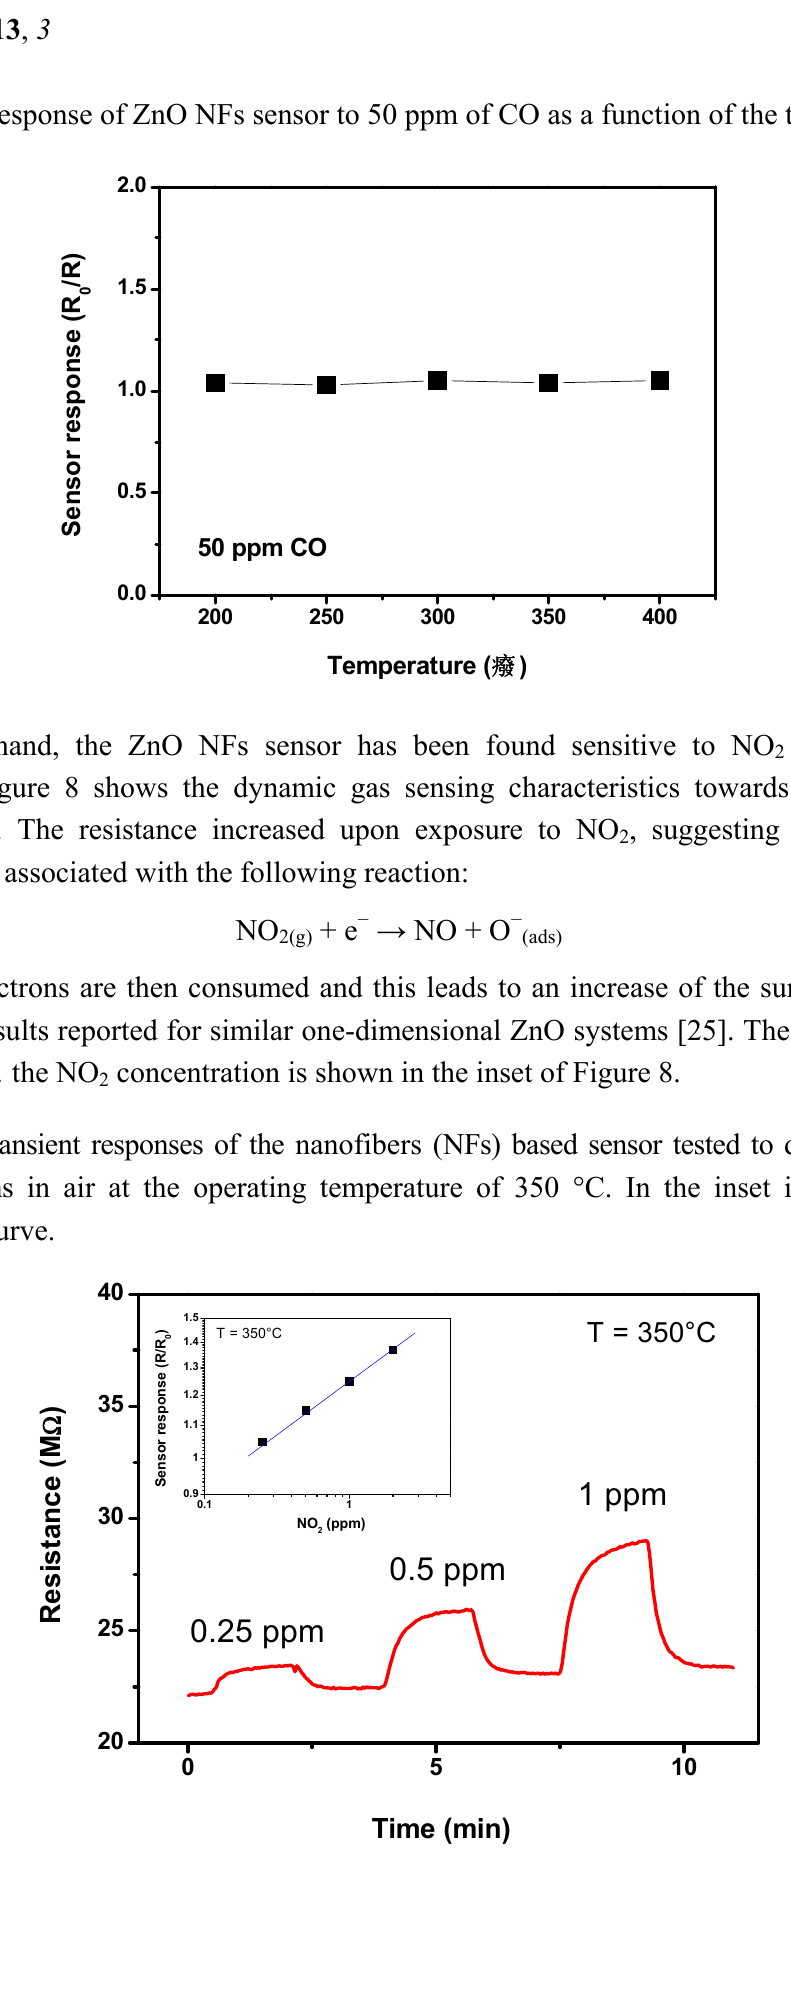
Figure 7. Response of ZnO NFs sensor to 50 ppm of CO as a function of the temperature.